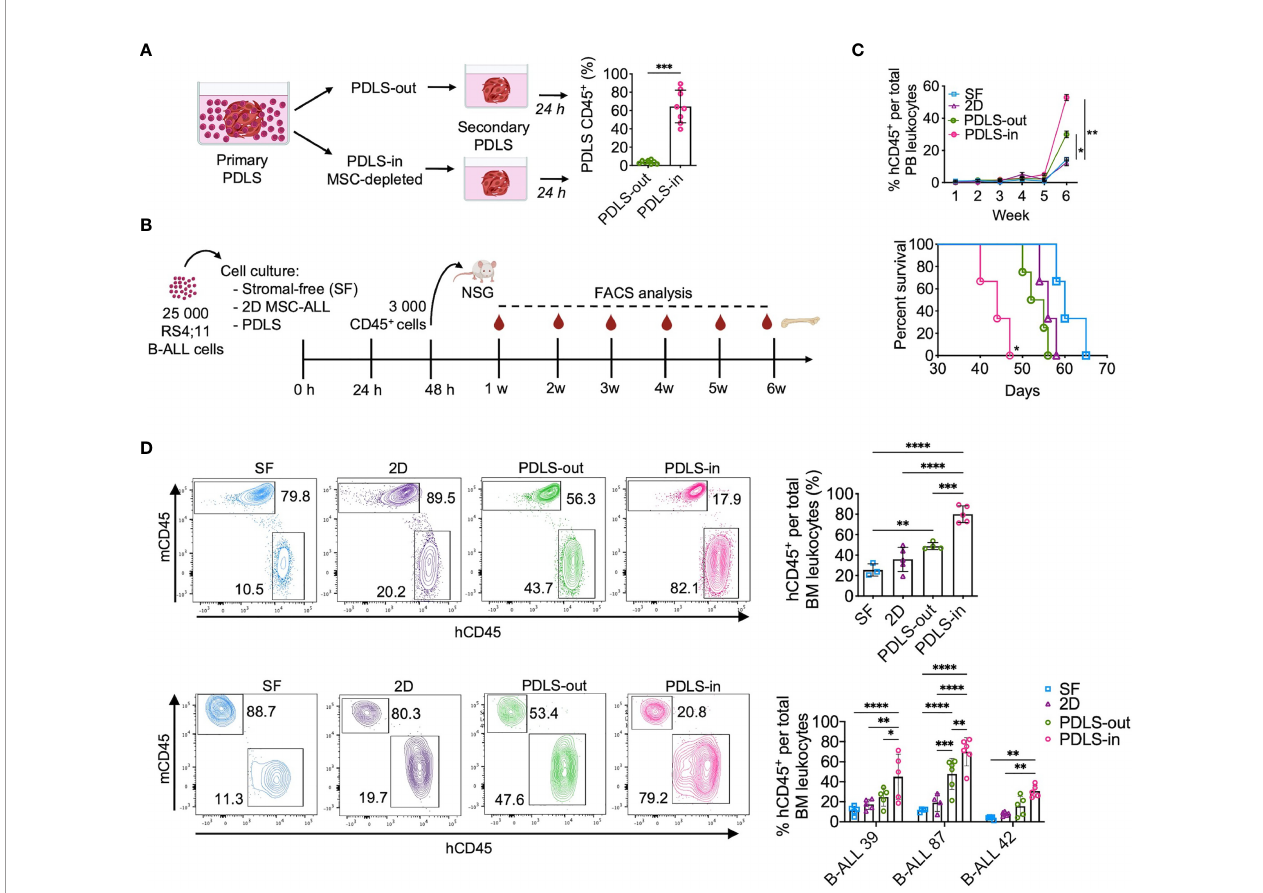
FIGURE 4 | Leukemia-initiating cells (LICs) are enriched in PDLS internal niches. (A) Secondary spheroid colonization assay was performed with puri fi ed PDLS-in and PDLS-out leukemic cells from primary PDLS ( n = 8). (B) Schematic representation of experimental design, Leukemic cells were cultured during 48 h on stromal- free (SF), MSC monolayers (2D), and PDLS and 3,000 CD45 + cells were transplanted into NSG mice. (C) Leukemia burden was monitored in peripheral blood by FACS (upper panel) and overall survival was plotted (lower panel) when RS4:11 cells were used ( n = 5). (D) Engraftment was determined in BM after 6 weeks of xenotransplantation of RS4:11 cells (upper panel) or three different primary B-ALL cells (representative plots are shown in lower panel) ( n = 5). B-ALL, B-cell acute lymphoblastic leukemia; PDLS, patient-derived leukemia spheroids; MSCs, mesenchymal stromal cells; FACS, Fluorescence-activated cell sorting. *P < 0.05; **P < 0.01; ***P < 0.001, ***P < 0.0001. Error bars represent